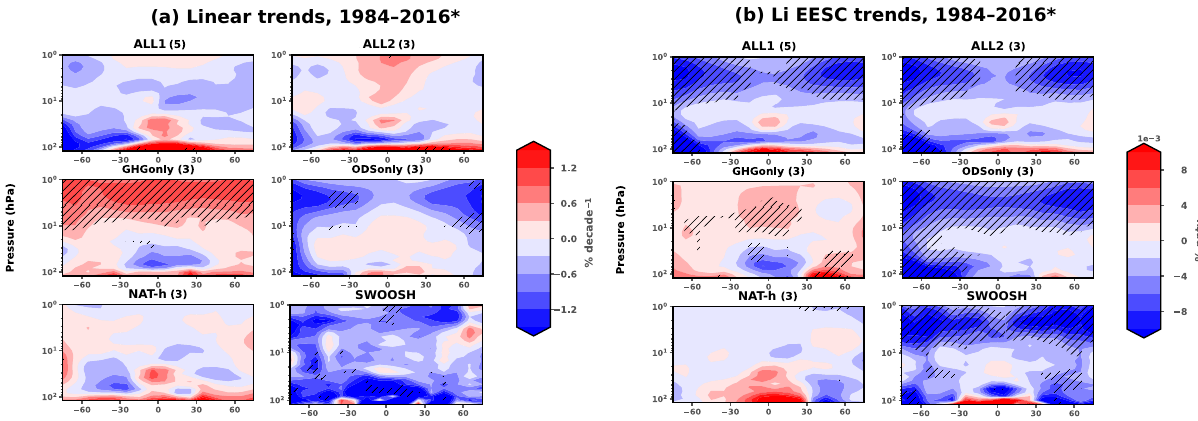
Figure 4. Zonal-mean stratospheric ozone trends estimated using (a) linear regression and (b) EESC regression of annual-mean anomalies from 1984 to 2016. For model simulations, trend estimates use the ensemble mean. Hatching indicates significance at the 5% level or better using a two-sided Student’s t test. Figures in brackets indicate the number of ensemble members. All of the trends shown are for 1984–2016, except for ALL1, which is from 1984 to